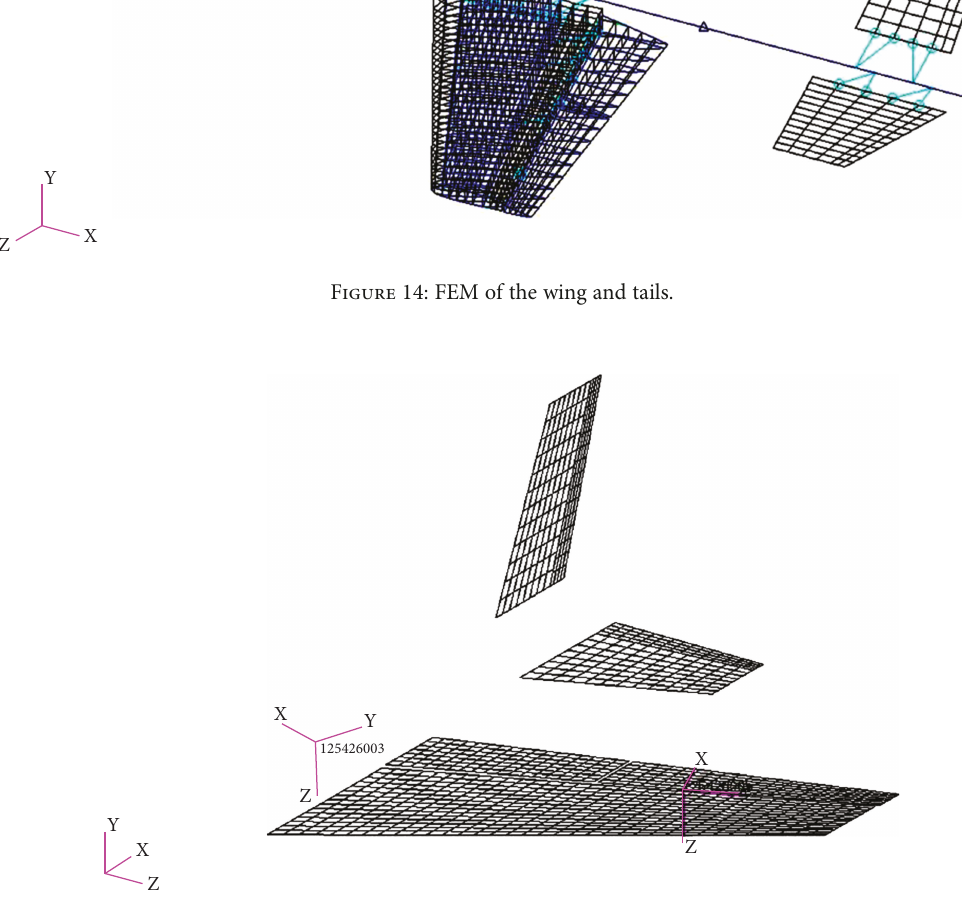
Figure 15: Aerodynamic meshes of the wing and tails.